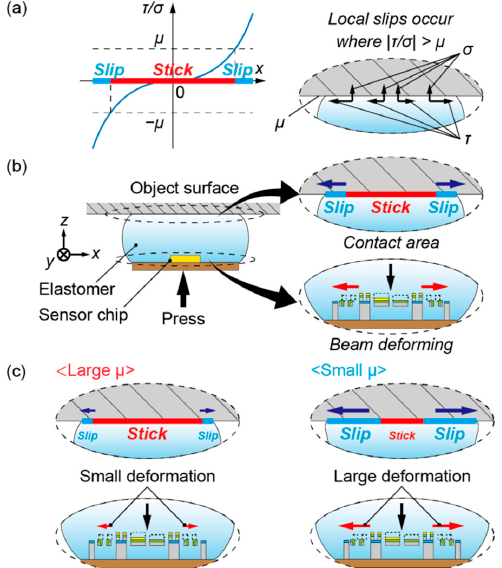
Figure 2. Measurement principle of the proposed sensor. ( a ) Mechanism of local slip on the contact area, where σ is the normal stress, τ is the shear stress and µ is the coefficient of static friction; ( b ) Situation where the sensor is pressed against an object surface; ( c ) Difference of deformations of the beams between large and small friction coefficients.